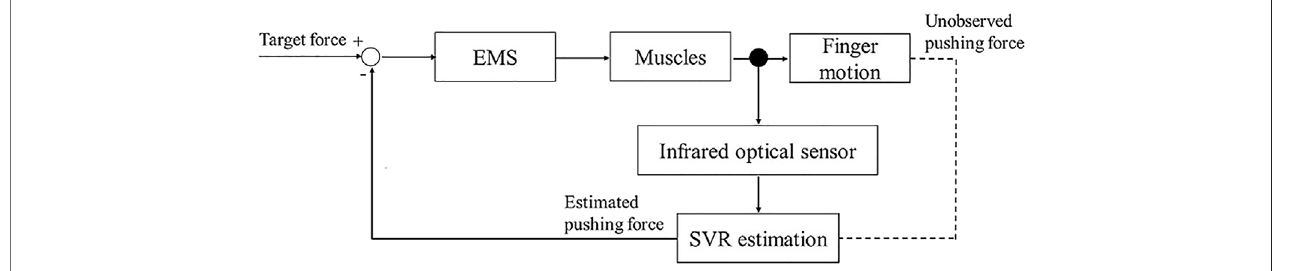
FIGURE 2 | Block diagram of the EMS amplitude control system. The pushing force estimated by infrared optical sensing values was used as a feedback value.